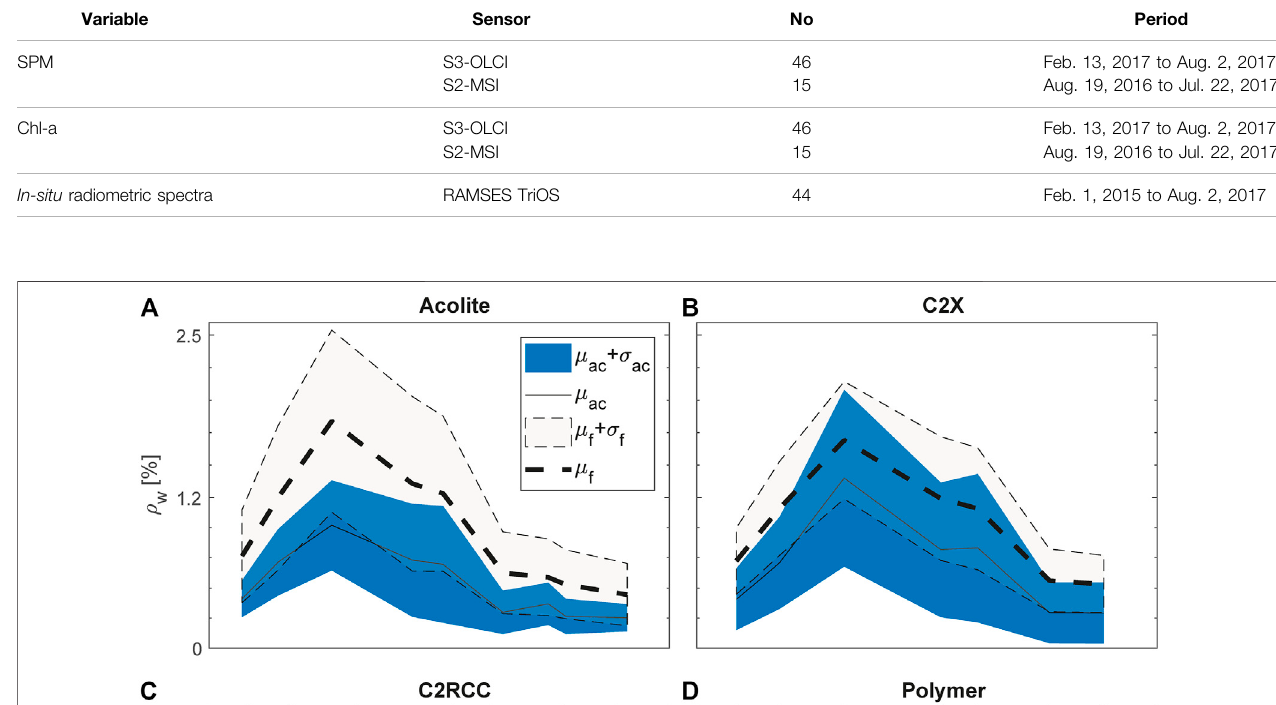
Frontiers in Remote Sensing |